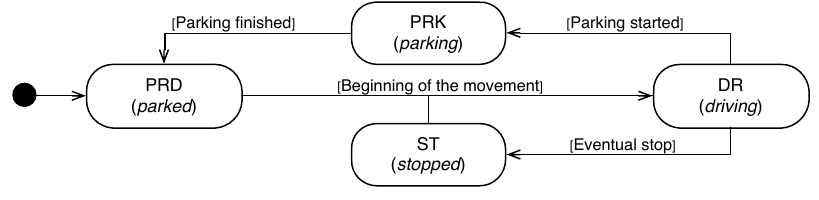
Figure 1. Target maneuvers and conceptual transitions among them.